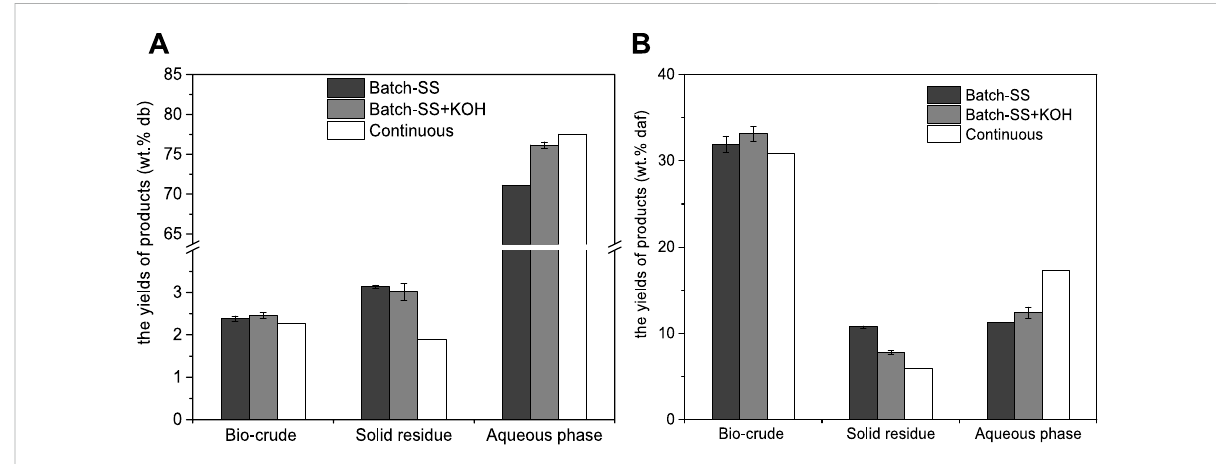
FIGURE 4 Comparison of product yields from batch and continuous fl ow HTL experiments with an SS loading of 10 wt% at 350 ° C with 8 min retention time, (A) on dry basis; (B) on dry-ash free basis.